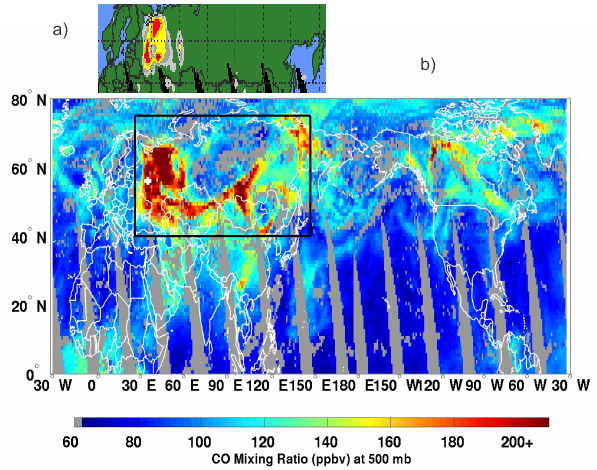
Fig. 6. Averaged over the area 40 ◦ –75 ◦ N, 30 ◦ –150 ◦ E CO TC val- ues (right scale) and corresponding burdens (left scale) according to operational data of MOPITT V4 and AIRS V5, as well as IASI retrieved using 3 different algorithms, in 2010. AIRS background line is shown as an example. The background line represents TC that is expected without wildfires and is plotted through the lowest points of data in 10-days